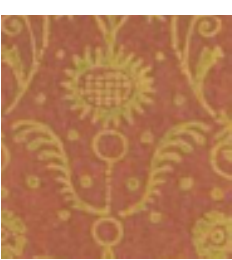
Fig. 38. Enlargement of the sunflower tool (not to scale) taken from the centre piece of a binding by Black on a copy of the 1767 Constitutions .